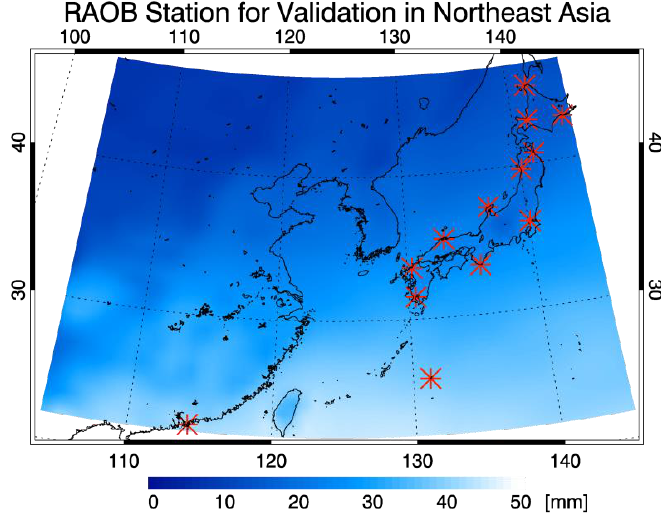
Figure 1. The red asterisks indicate 13 radiosonde observations (RAOB) sites with high accuracy for validation within the study area. The averaged ERA-Interim total precipitable water (TPW) from October 2016 to August 2018 was used as a background image. For a comparison between two reference data (i.e., RAOB and ERA-interim TPW), ERA-Interim TPW was collocated at the grid-point near the 13 radiosonde stations in Northeast Asia during the validation period. The comparison result is shown in Figure 2. The error metrics were calculated from 130 collocated matches over clear sky regions. Specifically, the two reference data agree with each other with mean bias (ERA-Interim TPW—RAOB TPW) of −0.56 mm and root mean square error (RMSE) of 2.78 mm.